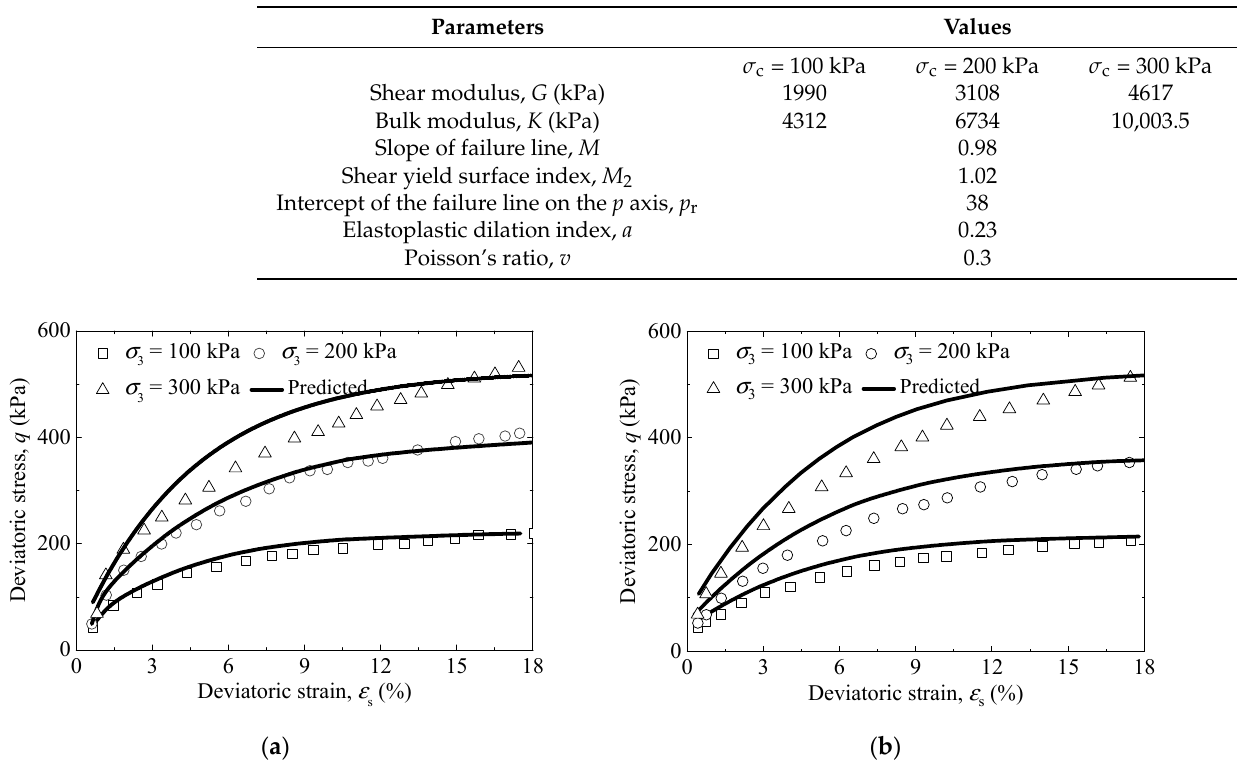
Table 2. Parameter values for the proposed elastoplastic model with N FT = 5 used in [36].